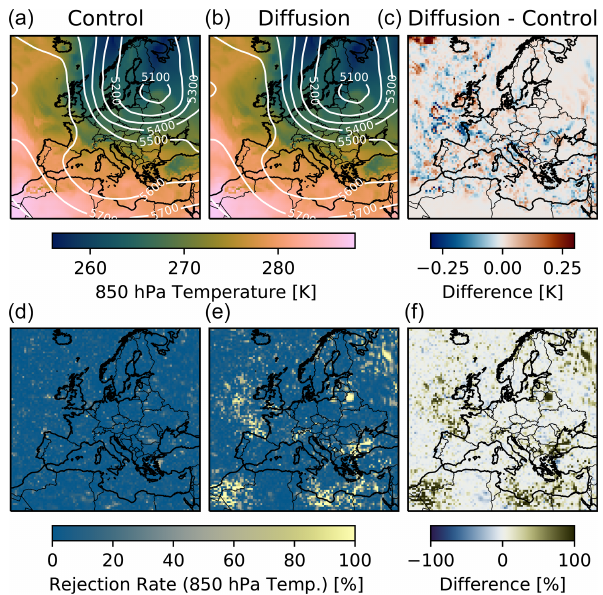
Figure 2. Panels (a, b, c) show the ensemble-mean 850hPa temper- ature (color shading) and 500hPa geopotential height (white con- tours) for the control ensemble (a, d) and diffusion ensemble with D = 0 . 01 (b, e) after 24h, using n E = 50 members per ensemble. The difference in mean temperature is shown in (c) . Panels (d, e, f) show the mean rejection rate for the 850hPa temperature (cal- culated with the MWU test for m = 100 subsamples with n S = 20 members per subsample) for each grid cell for these two ensem- bles, as well as the difference in rejection rate between them. The substantial differences in mean rejection rate indicate clearly that the two ensembles come from different